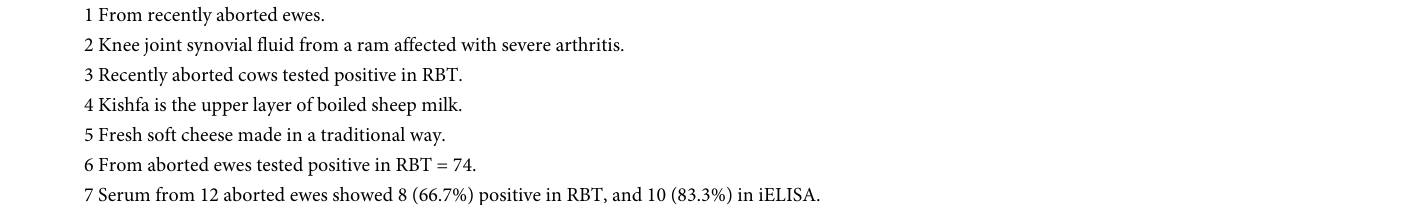
four studies assessed vaccines against brucellosis using B . melitensis strain Rev.1 administered subcutaneously or as conjunctival drops in ewes or goats (Table 4).